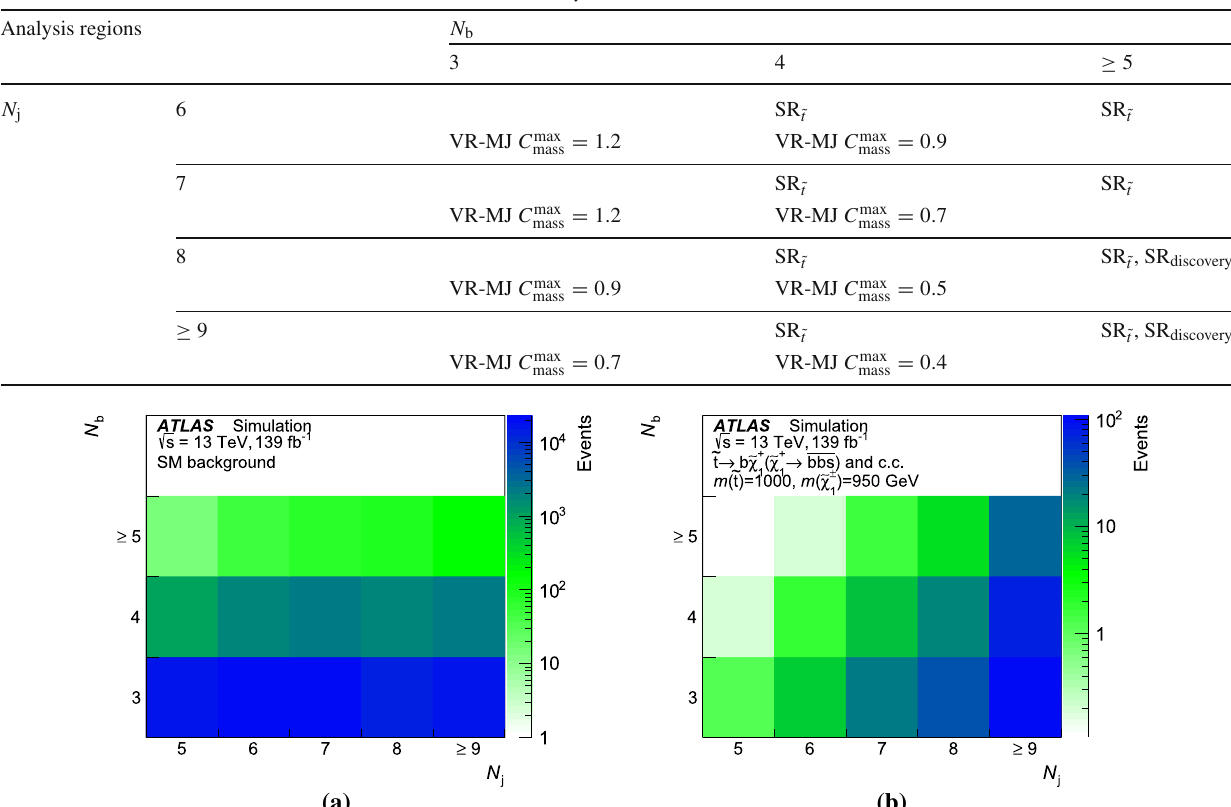
Table 1 The strategy of the analysis. For the model-dependent fit, the signal regions (SR ˜ t ) consist of events with N j = 6, 7, 8 and ≥ 9 jets and N b = 4 and ≥ 5. These are used independently in the final fit. For the model-independent fit, two dedicated signal regions (SR discovery ),